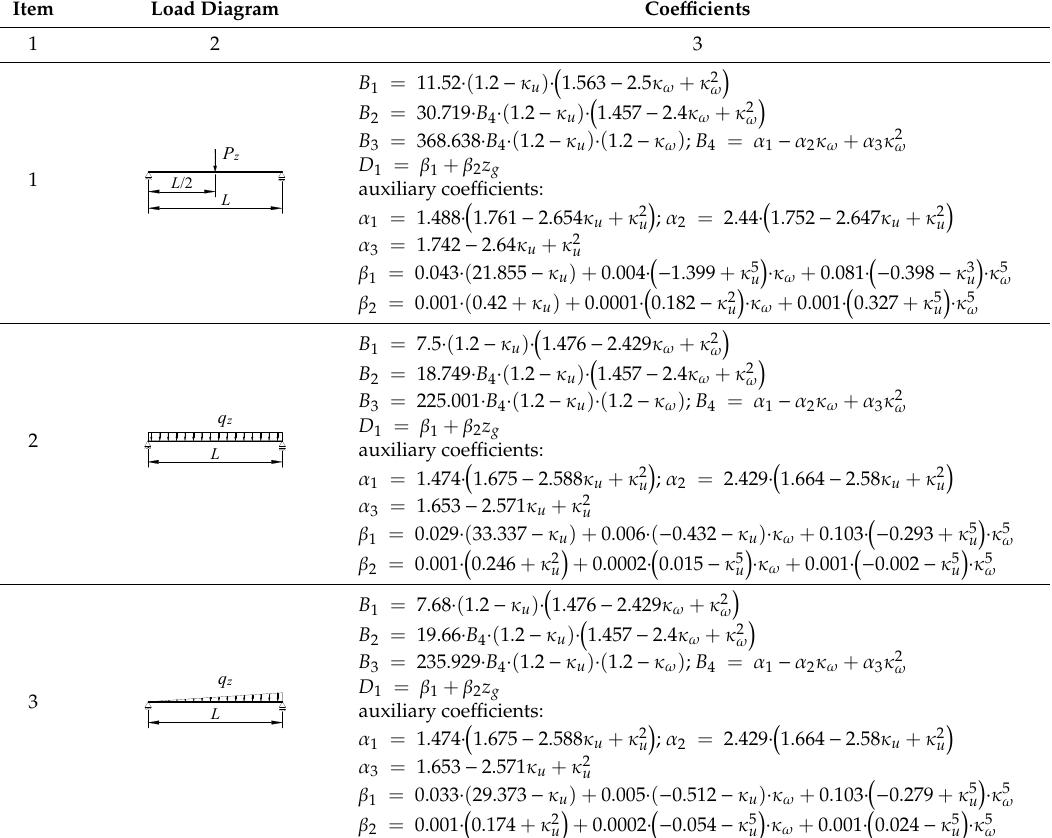
Table 2. Coefficients B 1 , B 2 , B 3 , B 4 and D 1 for selected diagrams of transverse load.